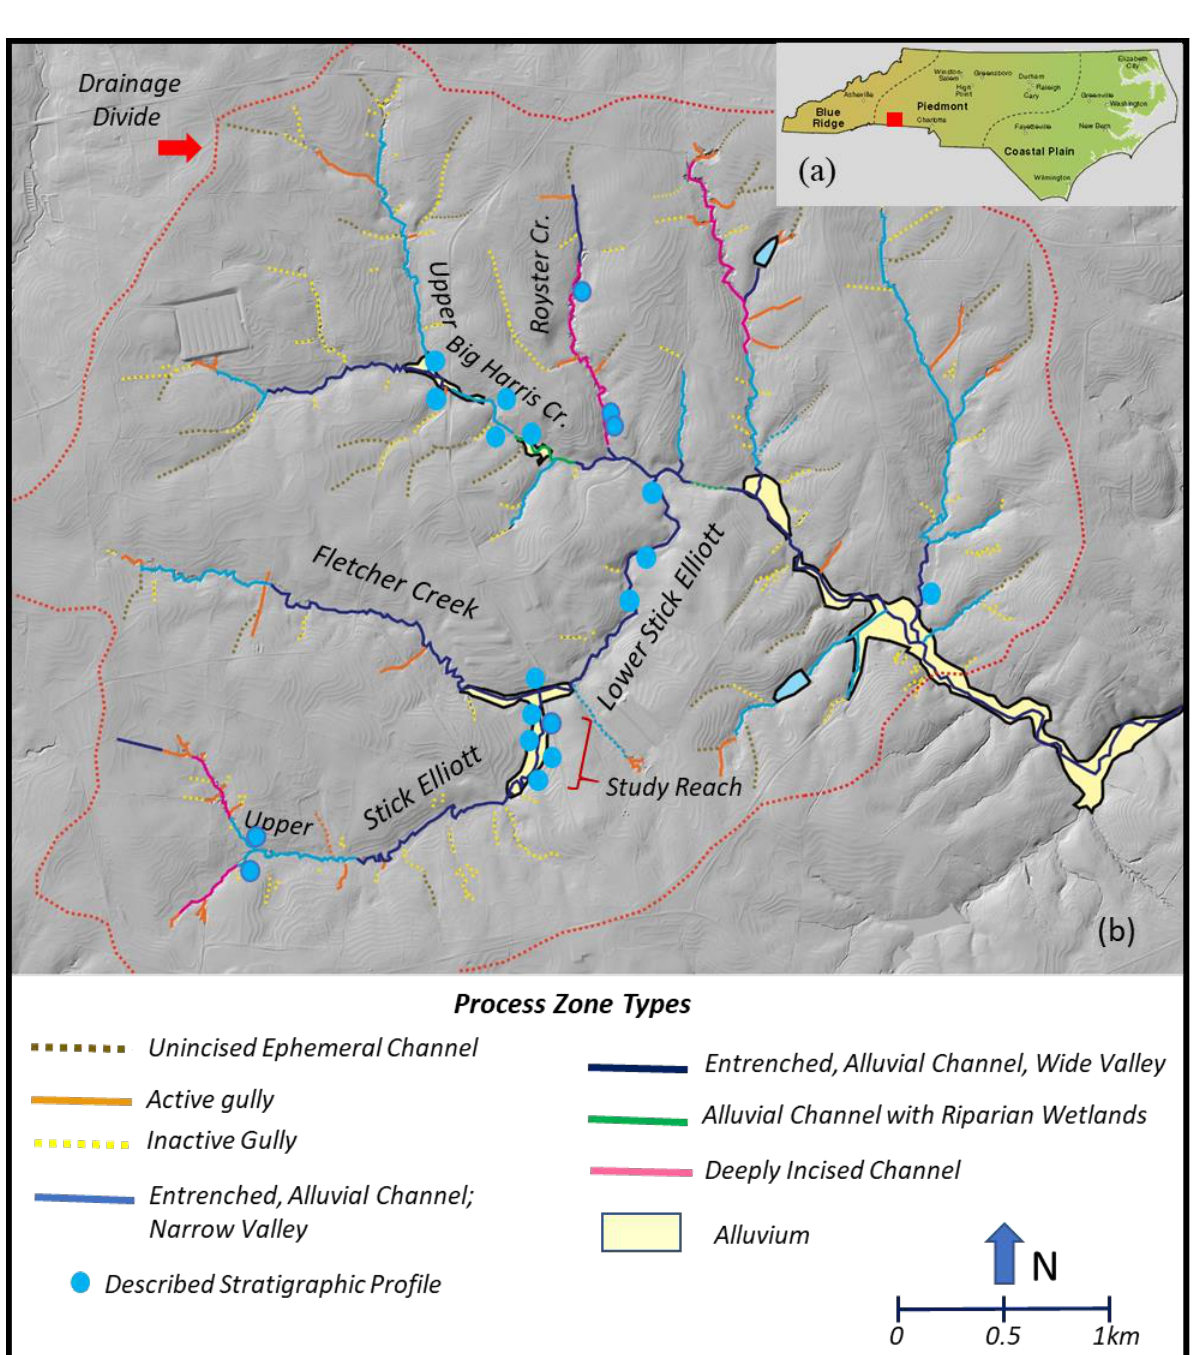
Figure 1. ( a ) Map showing the location of the Big Harris Creek basin in North Carolina; ( b ) Spatial distribution of the 7 defined process zones within the basin and the location of the described stratigraphic sections. Descriptions of process zones can be found in Miller et al. [30]. Mapped areas of alluvium are characterized by legacy sediments overlying precolonial deposits. North Carolina map is from the USGS. LiDAR DEM from the North Carolina Spatial Data Download Center (https://sdd.nc.gov/, accessed on 10 October 2021).